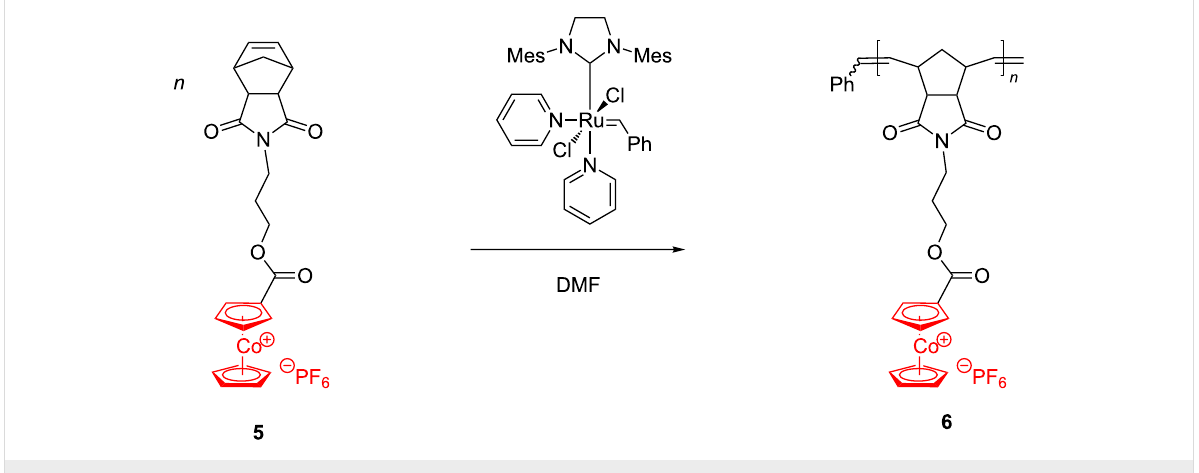
Scheme 3: Synthesis of cobaltocenium-containing polymers by ROMP.